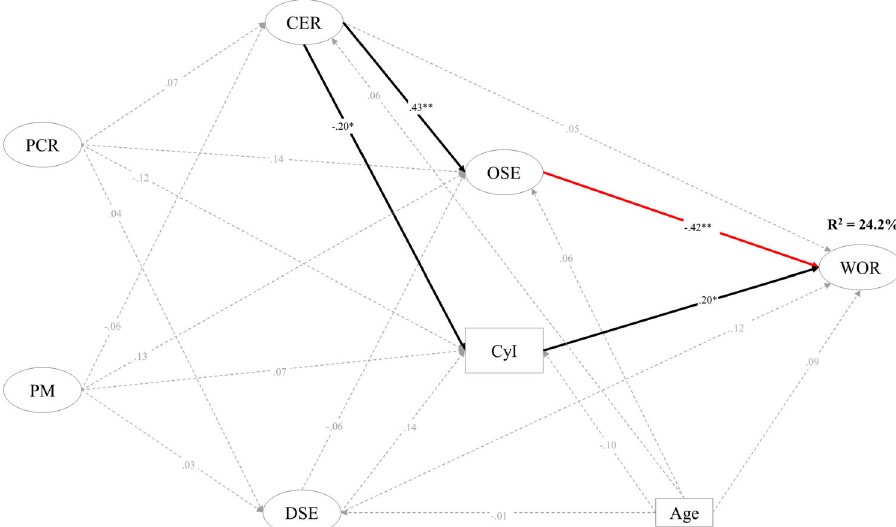
Fig. 3 Results of the multiple-group structural equation modeling (Male group). PCR Parent-child relationship improvement, PM Parental monitoring, CER Cognitive-emotional regulation, DSE Digital activities for socialization and entertainment, OSE Online learning self-ef fi cacy, CyI Cyberbullying involvement, WOR Perceived worries for future study and life. Black arrows represent statistically signi fi cant direct effect, dotted arrows represent statistically insigni fi cant direct effect, and red arrow represents statistically signi fi cant different direct effect between male group and female group. * p < 0.05. ** p <